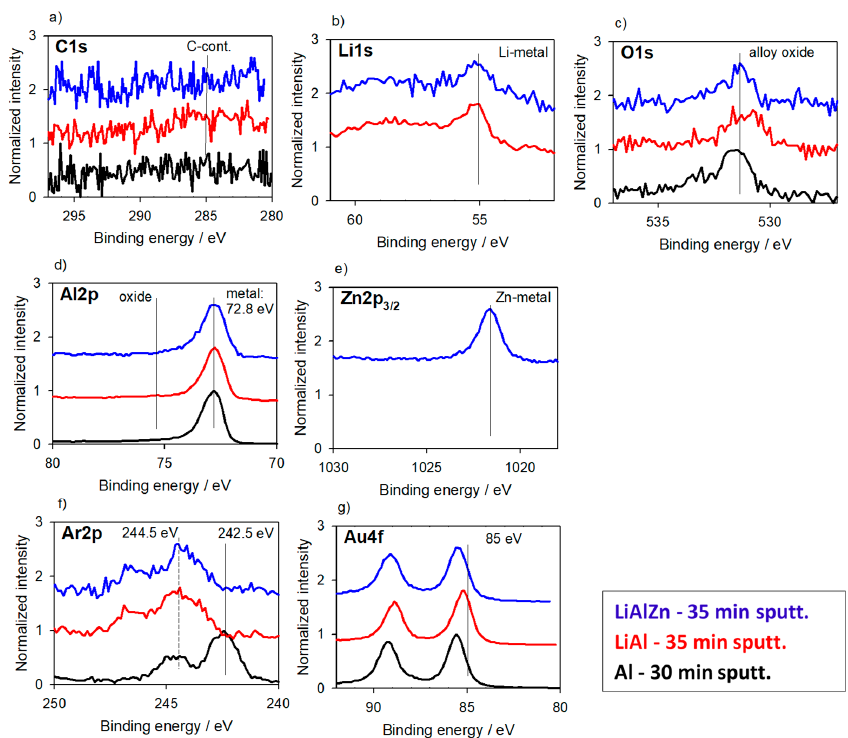
Figure 7. XP spectra normalized in intensity of an Al-foil and melt-processed LiAl- and LiAlZn-material after intense sputter cleaning ( bottom to top ). BE was calibrated with Al2p (72.8 eV—metal). Whereas the Au4f metal peak of the Au sputter reference remains unchanged (around 85 eV), the Ar2p peak from implanted Ar is clearly shifted for the Li containing samples to high BE. Li1s is mainly found at its metallic position (55 eV). ( a ) C1s; ( b ) Li1s; ( c ) O1s; ( d ) Al2p; ( e ) Zn2p 3/2 ; ( f ) Ar2p; ( g ) Au4f